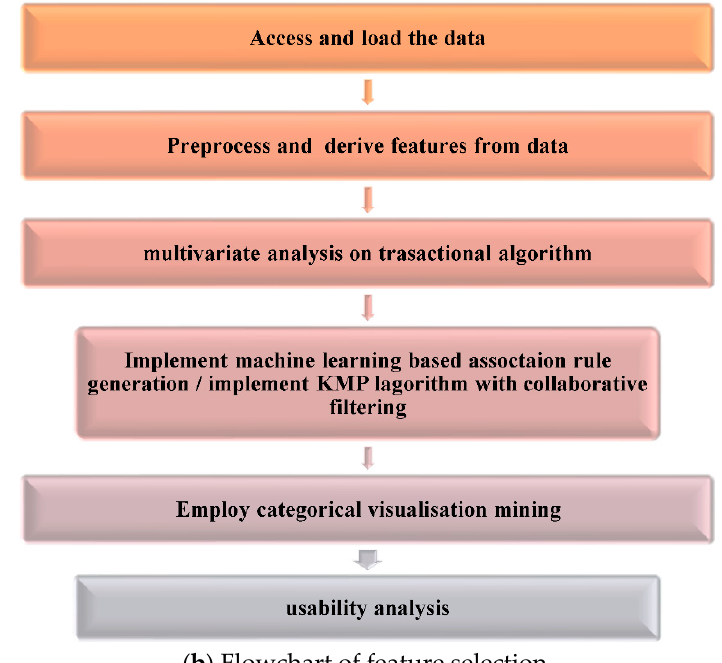
( b ) Flowchart of feature selection. Figure 3. Proposed method. Figure 3. Proposed